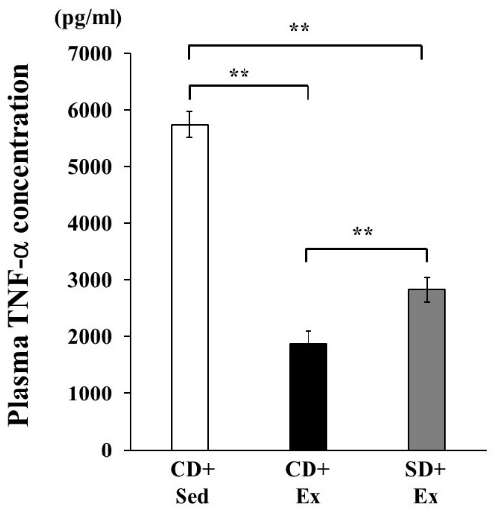
Figure 1. The effect of exhaustive exercise and Sparassis crispa intake on plasma tumor necrosis factor (TNF)- α concentration in response to lipopolysaccharide (LPS) injection in mice. Values are means ± SEM. CD + Sed ( n = 8): normal diet + sedentary, CD + Ex ( n = 10): normal diet + exercise, SD + Ex ( n = 10): S. crispa diet + exercise. ** p < 0.01.